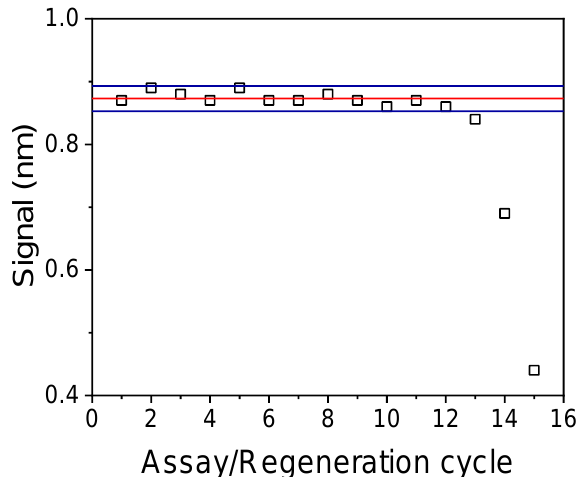
Figure 6. Responses obtained from a single chip for 15 consecutive assay/regeneration cycles. Red line corresponds to the mean value of the first 12 cycles and blue lines to the mean value ± 2SD limits.